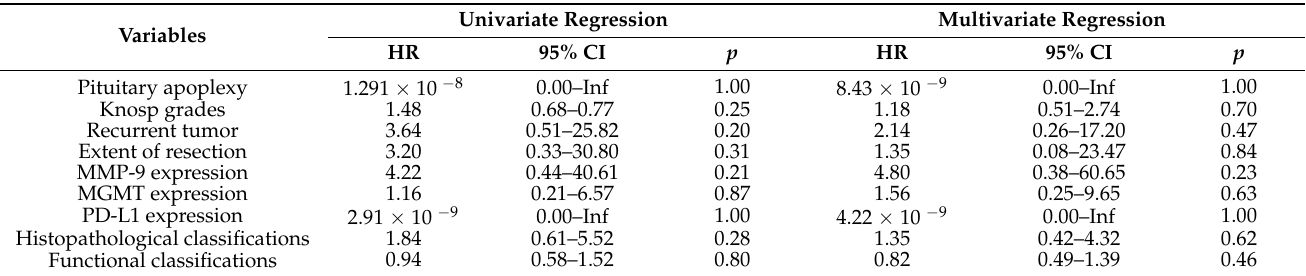
Table 2. Univariate and Multivariate Cox Regression Analysis for Survival.